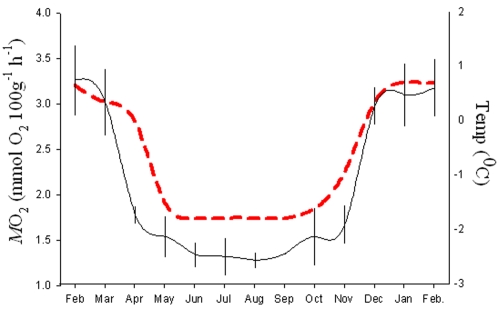
The free-ranging metabolic rate of N. coriiceps.
The mean monthly MO2 of wild N. coriiceps (black line, n = 6) was extrapolated from continual field recordings of f
H using the equation given in Fig. 3. Water temperature was measured by an onboard temperature sensor (red).